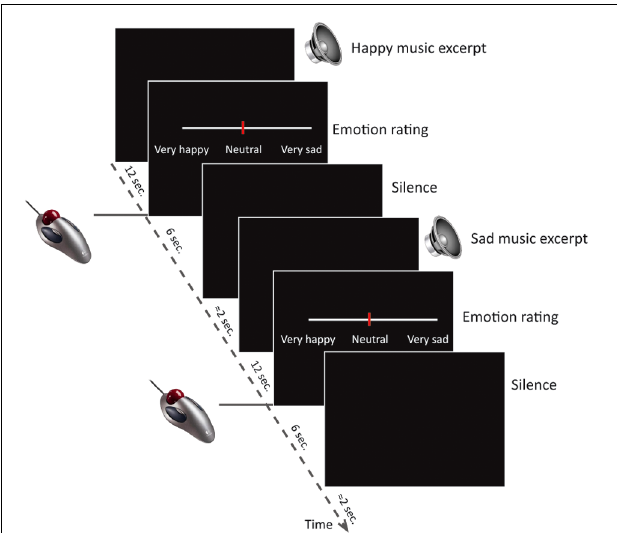
FIGURE 1 | Study design. The study consisted of 60 trials (20 happy, 20 sad, 20 neutral) inside the MR scanner. Each trial consisted of a musical excerpt of 12s duration, followed a visual analog scale depicted on the screen in front of the participant for 6s while participants indicated their emotion intensity ratings by using an MR-compatible scroll-ball mouse. After the rating there were approximately 2s silence before the next trial